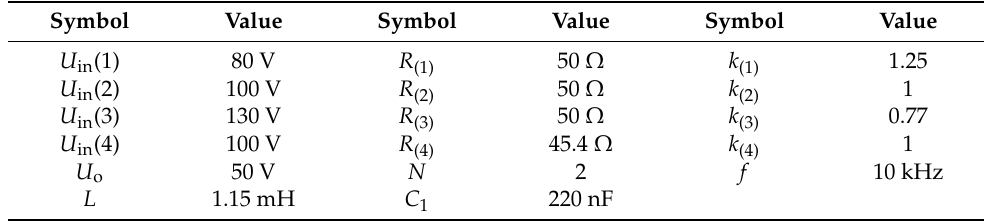
Table 2. Main experimental